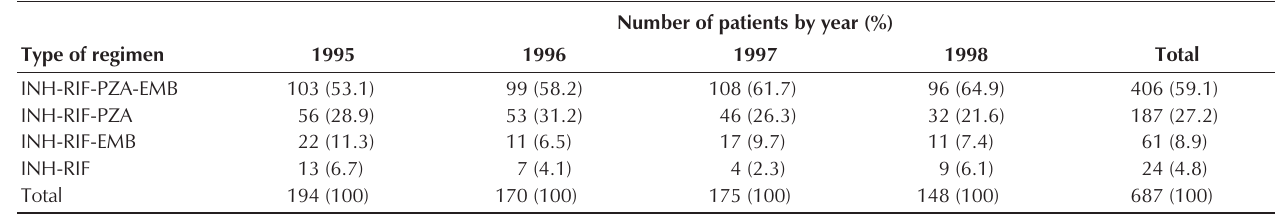
EMB Ethambutol; INH Isoniazid; PZA Pyrazinamide; RIF